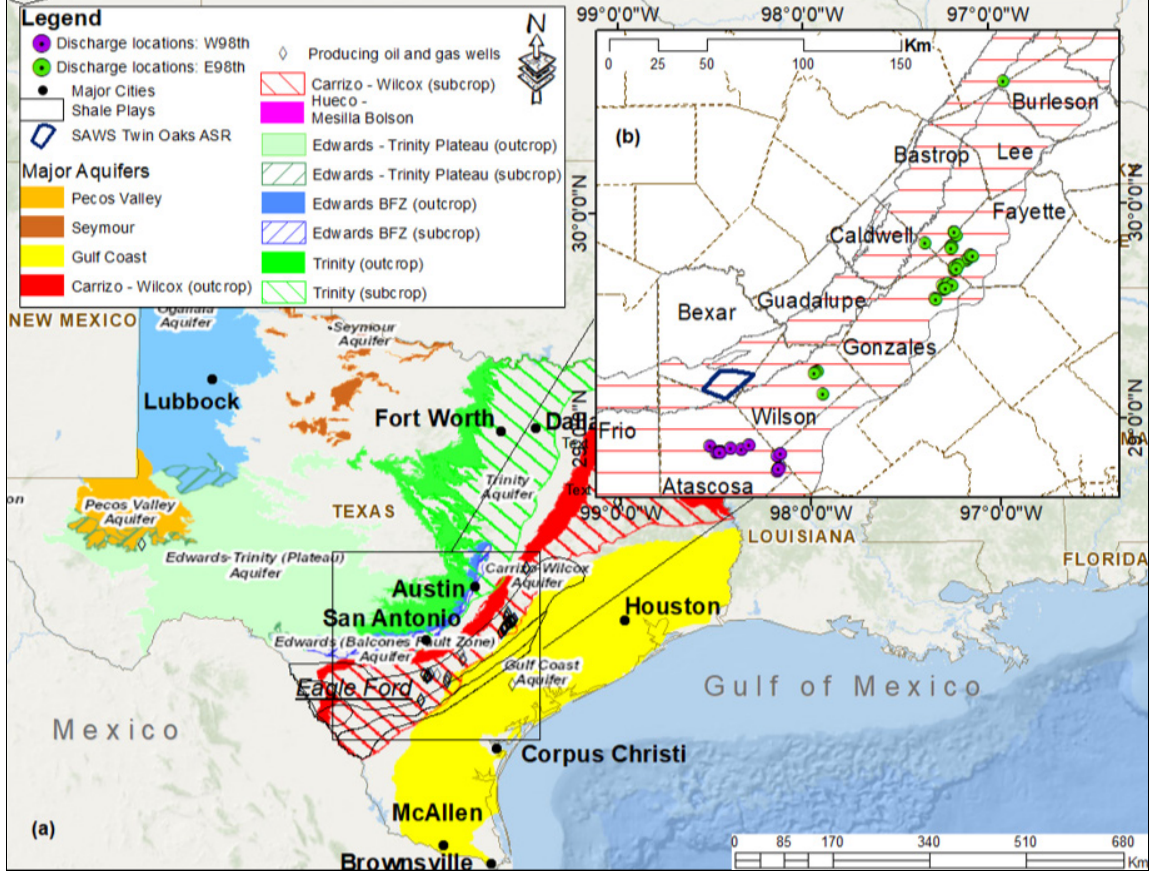
Figure 1. Location map of the study area including location of oil and gas wells (a) associated with surface discharge permits for low total dissolved solids produced water (b). In (b), the location of Carrizo-Wilcox Aquifer outcrop and subcrop are identified by the red line filed region. In (a), the San Antonio Water System aquifer storage and recovery area includes the injection and recovery